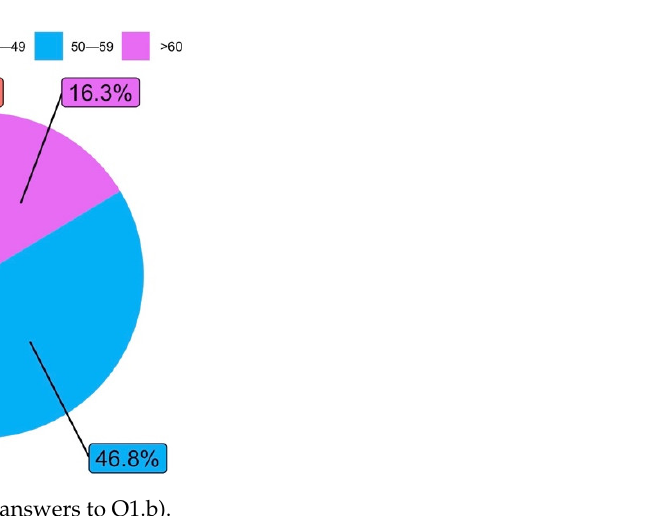
Figure 5. Workload of virtual teaching compared to face-to-face teaching (answers to Q2). The number of hours spent by teachers on student inquiries by email and/or vide- oconference (Q5, Q6) and the frequency of inquiries about Bachelor or Master Theses (Q7) were two of the most worrying aspects. Regarding the increase in e-mail inquiries in this non-face-to-face teaching period, the sum of teachers who stated that they had increased between 50% and 100% or even more was 49.6%; 52.1% stated that the hours devoted to student consultations by videoconference had been between 0 and 3 h per week. The ques- tions related to the Bachelor or Master Theses have had a diversity of answers with dif- ferent casuistry, of which it stands out that for 31.2% of the answers, the teaching staff considers that the frequency of the consultations had not increased, and a 23.9% answered that the frequency of consultations had doubled. 3.1.3. Reconciliation Regarding the reconciliation of teaching activity during the health crisis with per- sonal life, faculty were asked “How do you reconcile teaching activity throughout the health crisis with personal life with respect to the normal situation?” (Q3). Almost half of